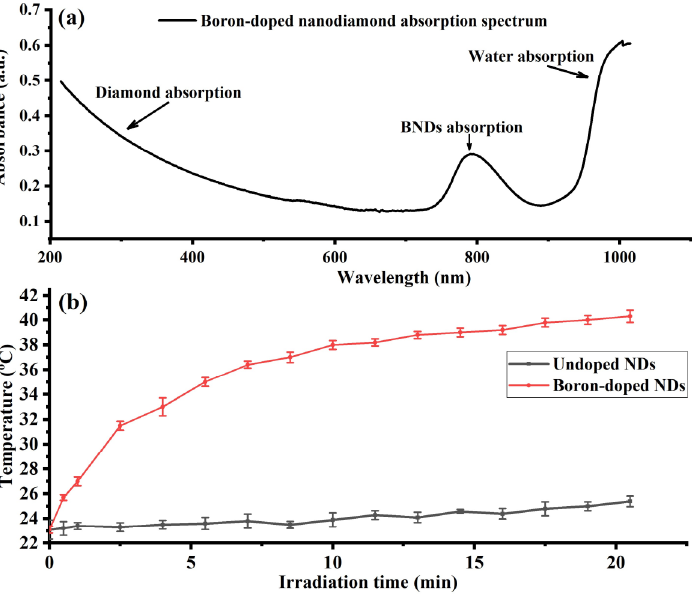
Figure 1. ( a ) Boron-doped nanodiamonds’ absorption spectrum recorded over the UV–VIS–NIR regions. BNDs show a relatively good absorption around the wavelength of 800 nm. ( b ) Comparison of temperature rise of 1 mg/mL of undoped NDs and BNDs dispersed in 2 mL of distilled water under 808 nm laser irradiation at 50 W · cm − 2 for 20